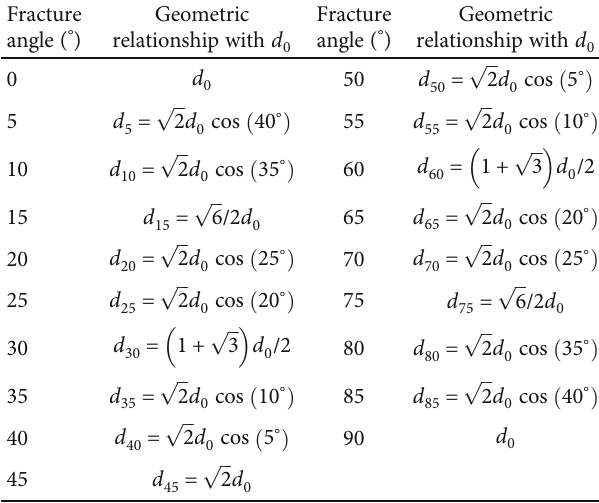
Table 2: Relationship between fracture distance d